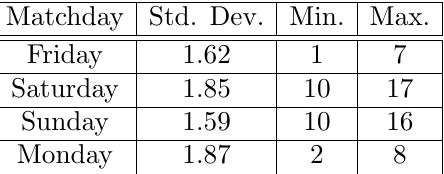
Table 7. Summary statistics for the manual schedule in the entire season. Matchday Std. Dev. Min. Max.